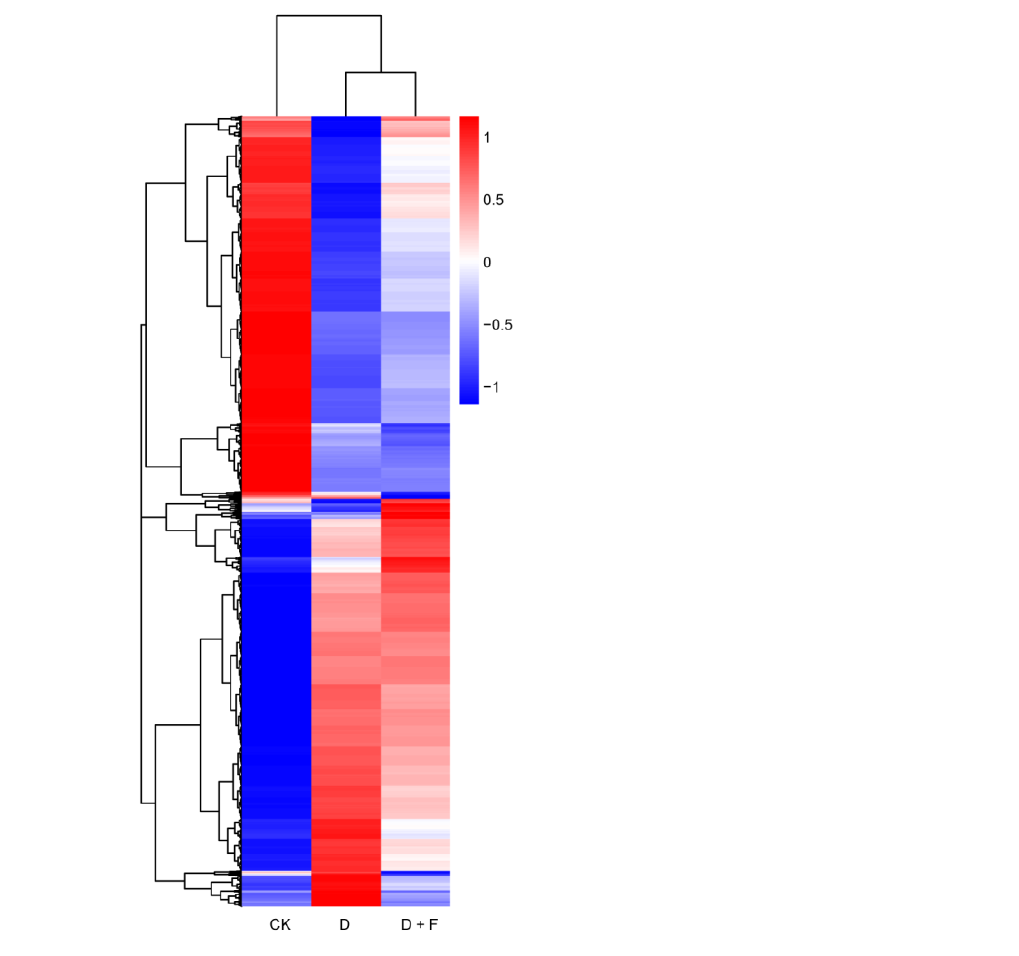
Figure 3. Hierarchical cluster analyses of differentially expressed genes in leaves of B. napus after drought and fullerol treatments. CK: check (sufficient water condition); D: drought; F: